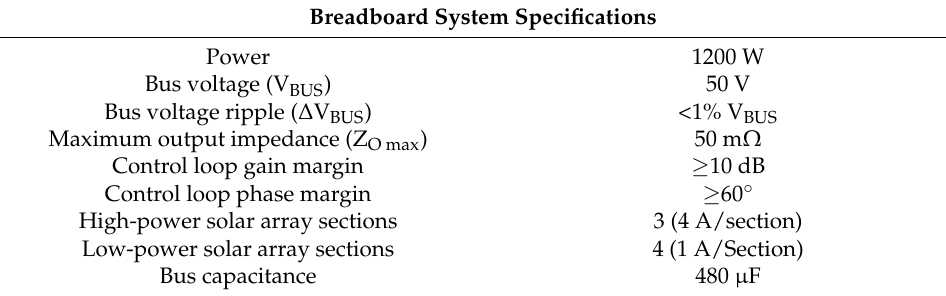
Table 3. Breadboard system